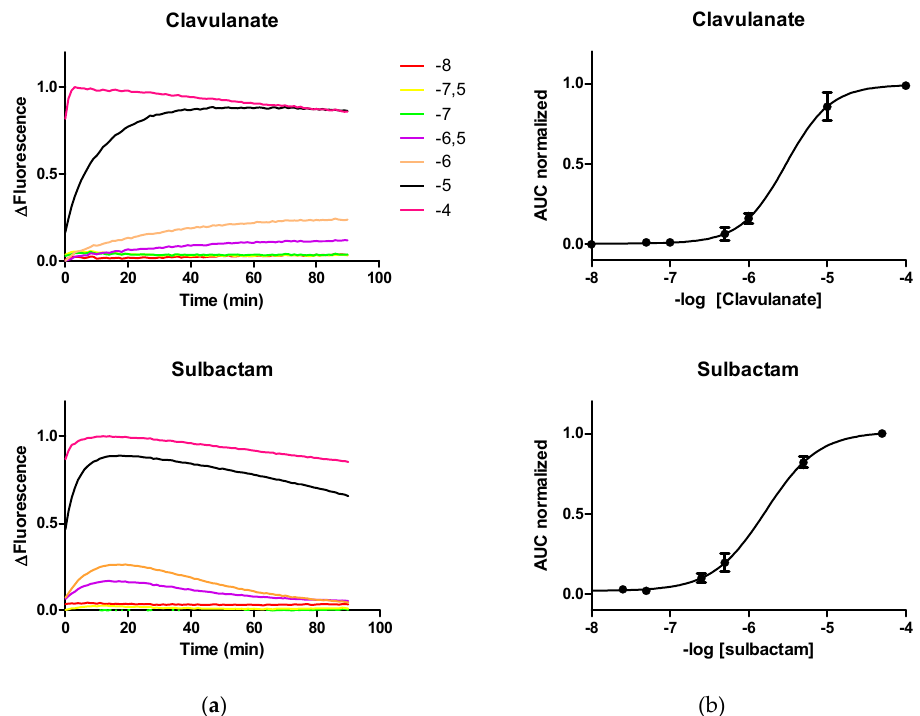
Figure 2. Time-course fluorescence of PenP at different concentrations of clavulanic acid ( a ) and sulbactam ( b ) Boltzmann curves, for each inhibitor, of each area under the curve normalized of fluorescence against -log concentration of antibiotic.